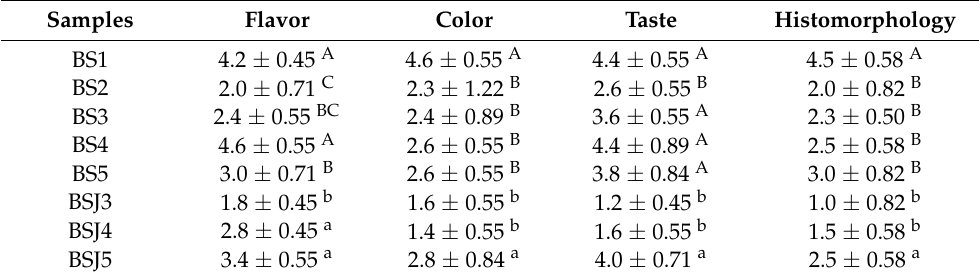
Table 1. Sensory characteristics analysis of